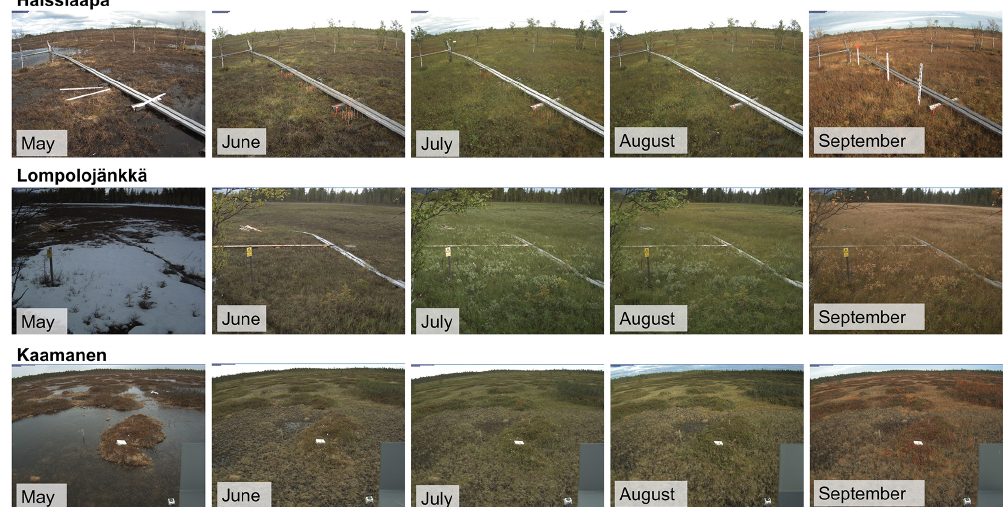
Figure 3. The seasonal development of vegetation and surface water from May to September in 2015 at Halssiaapa, Lompolojänkkä and Kaamanen. The pictures were taken on the 15th of each month.